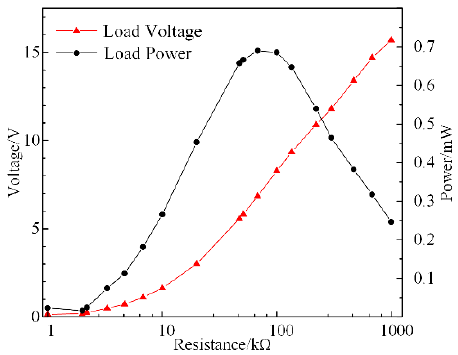
Figure 5. Closed-circuit voltage and power versus resistance of SPEH.